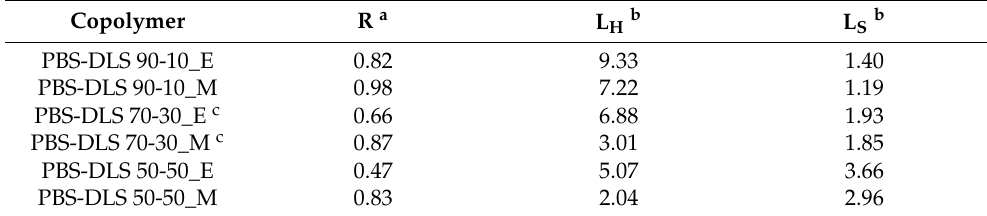
Table 1. Average sequence length of hard and soft segments and degree of randomness.